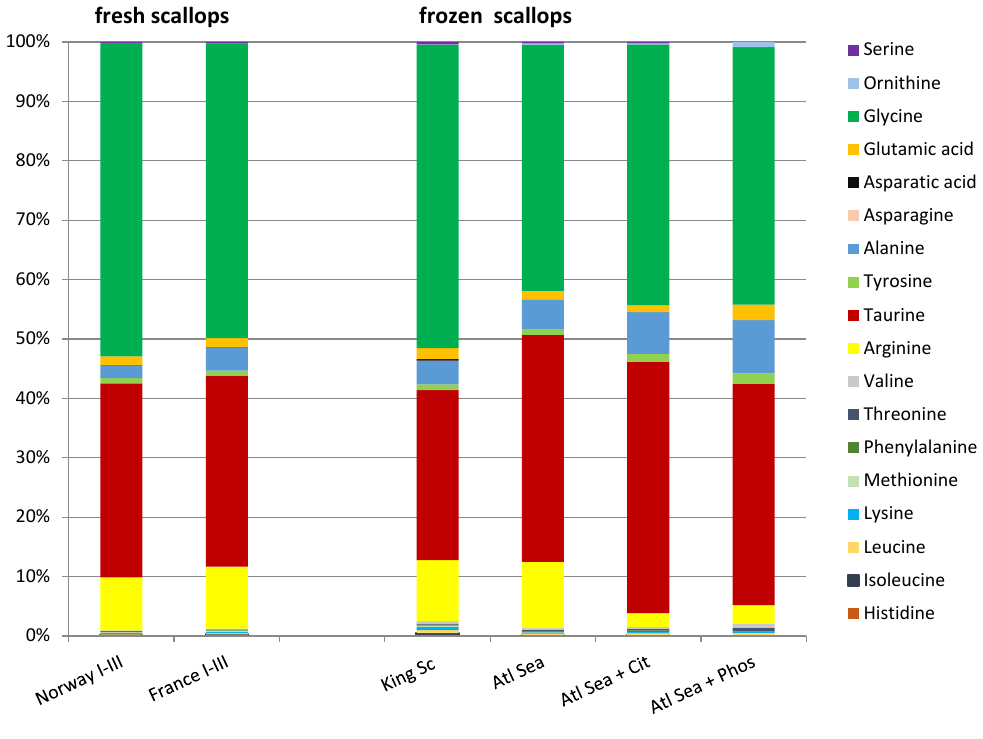
Figure 2. Average percentage composition of free amino acids in fresh king scallop meat (Norway I-III, France I-III), frozen king scallop meat (King Sc), and Atlantic sea scallop meat with either no additives (Atl Sea), or an addition of citrate (Atl Sea + Cit) or phosphate (Atl Sea +